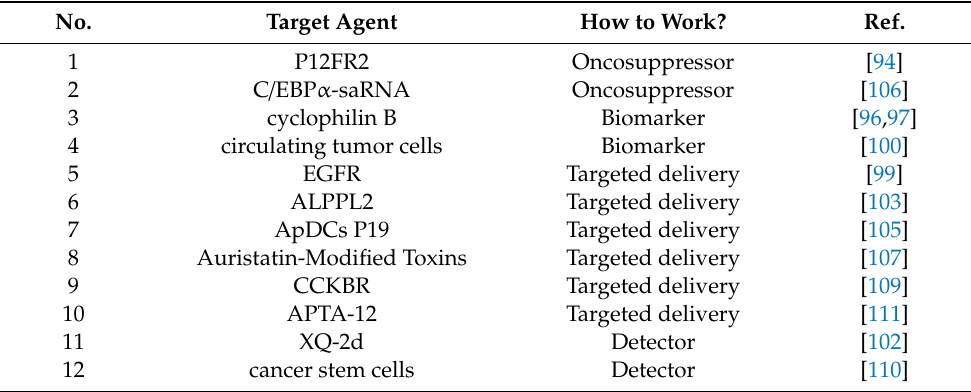
Table 3. Current studies of aptamer for pancreatic